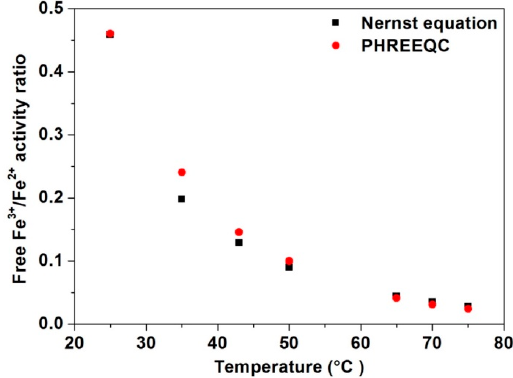
Figure 2. Comparison of the free Fe 3+ /Fe 2+ activity ratio calculated using the Nernst Equation (Equation (2)) and the PHREEQC solution speciation simulation software.